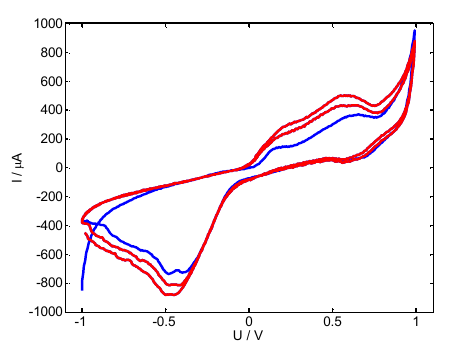
Fig.4: Cyclic voltammogram of two different gold electrodes in 140 mM PBS (phosphate buffered saline). The electrode area was 2 cm 2 and the voltage slope was set to 50